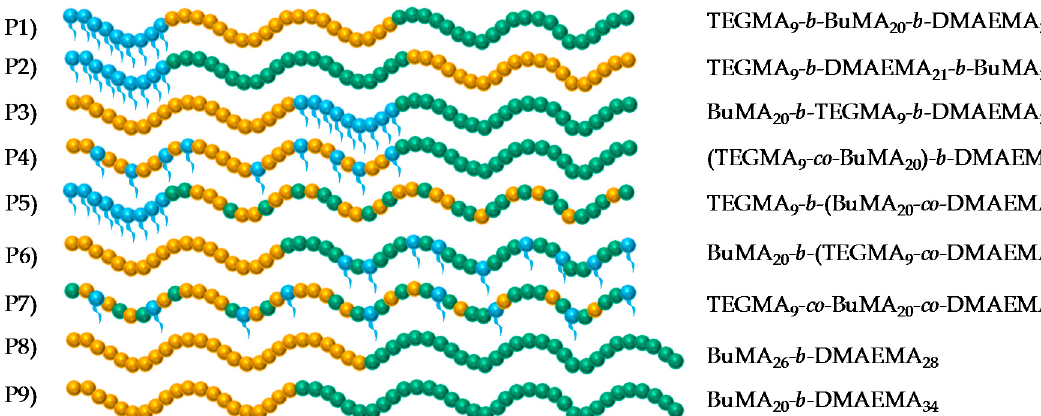
Figure 2. Schematic showing the structures of all the copolymers studied. Blue, orange, and green colors represent the TEGMA, BuMA, and DMAEMA units, respectively.